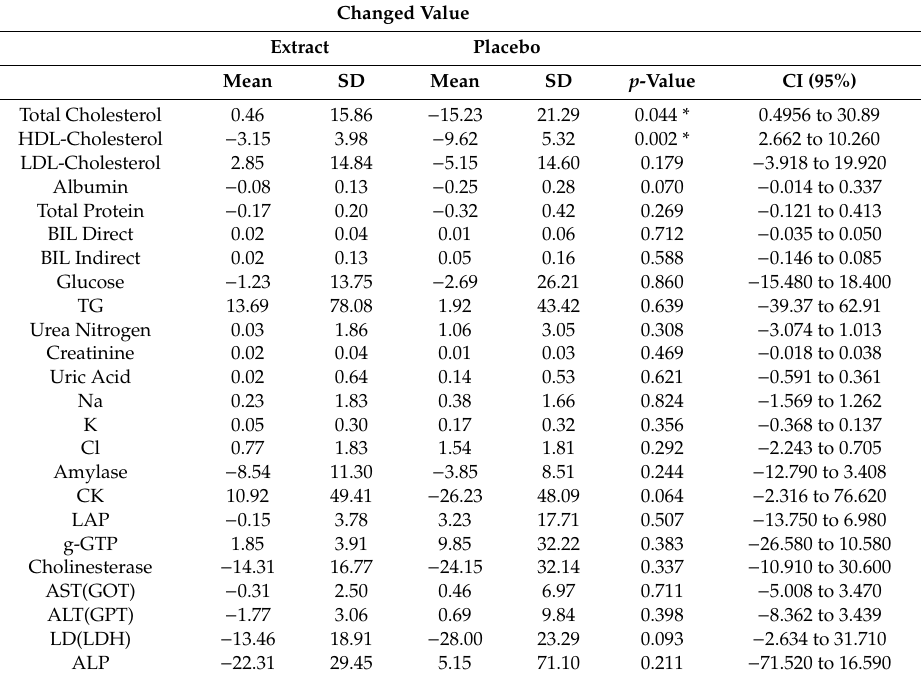
Table 5. Changes in blood data between ES extract plus DR extract intake and placebo